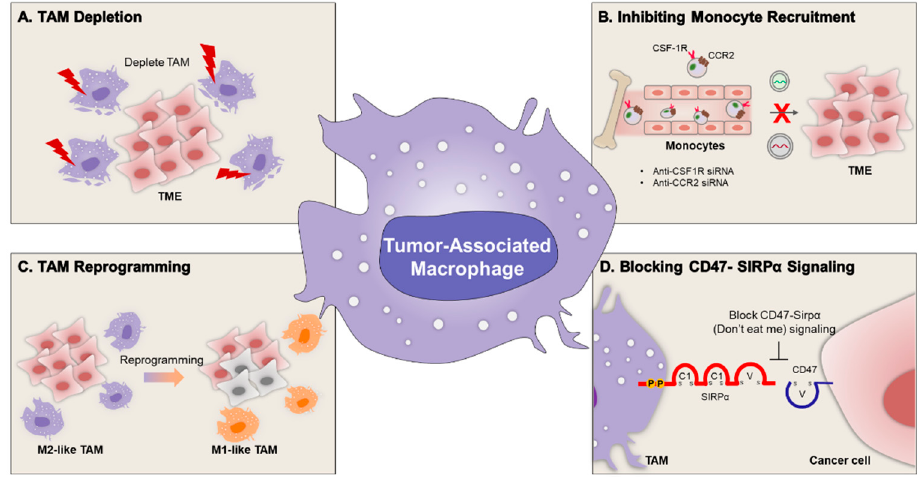
Figure 1. Nanoparticle-based strategies targeting tumor-associated macrophage in the tumor microenvironment. ( A ) Depletion of macrophages in tumor tissues; ( B ) inhibition of monocyte recruitment; ( C ) reprogramming of M2-type TAM to anti-tumoric M1-type macrophage; and ( D ) blockade of CD47-Sirp α signaling.